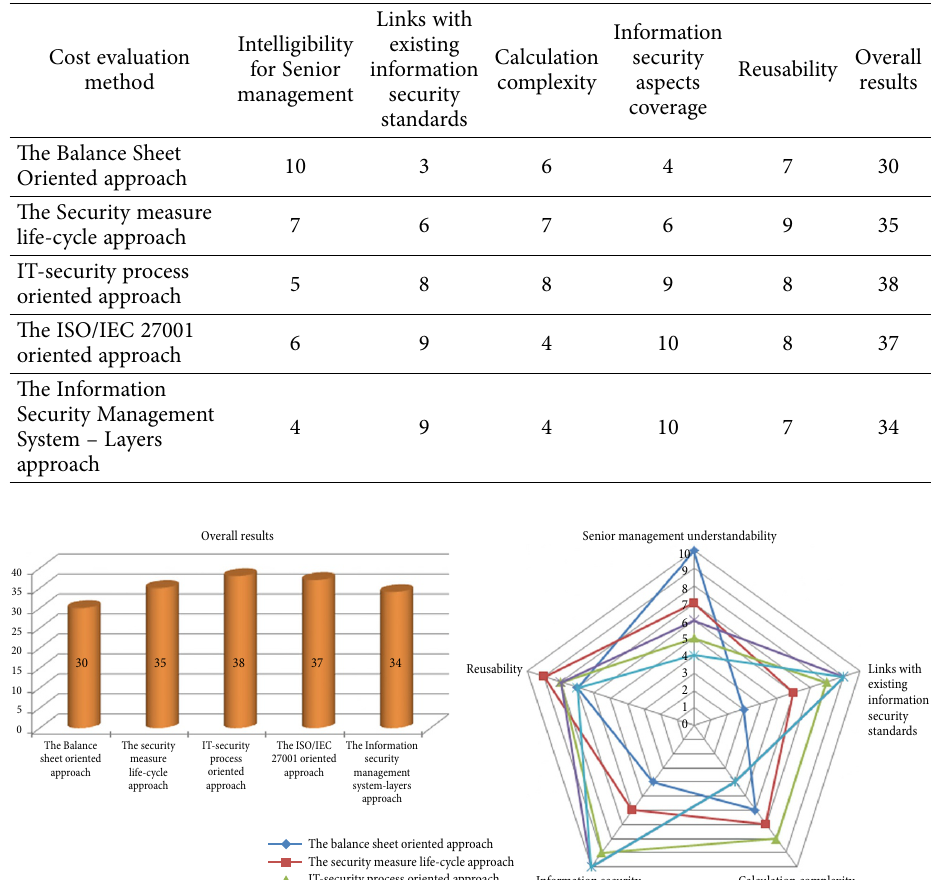
Table 2. Information security costs implementation methods evaluation